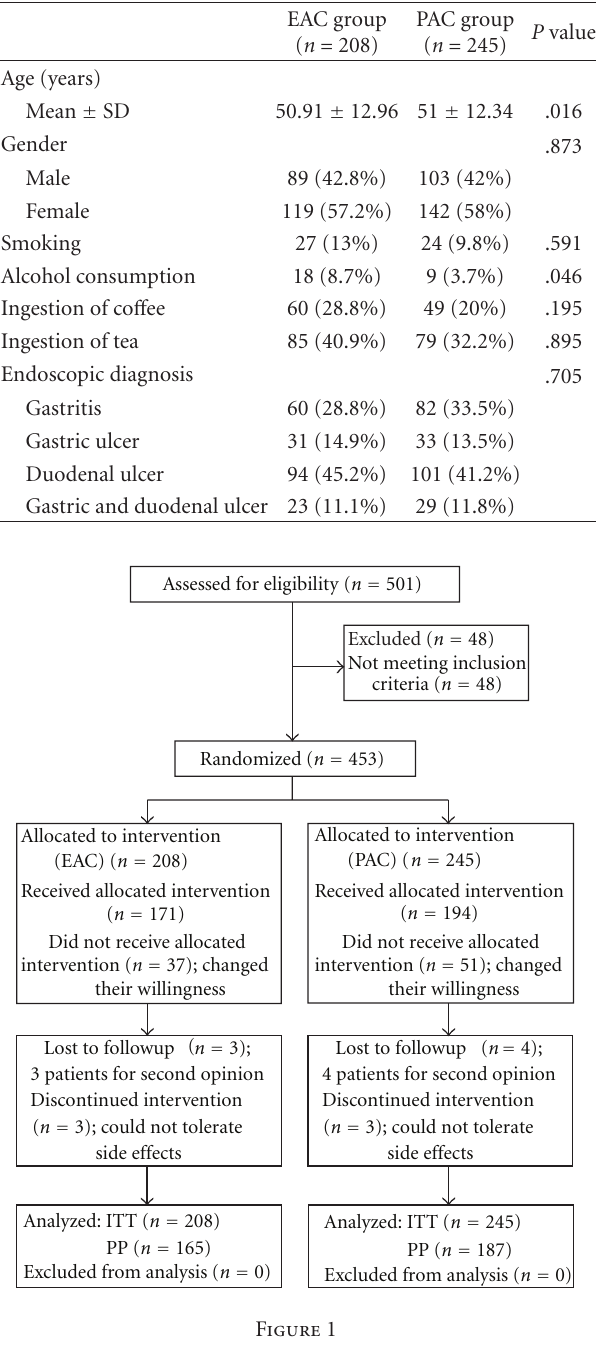
Table 1: Demographic distribution and Endoscopic diagnosis of two patient groups.